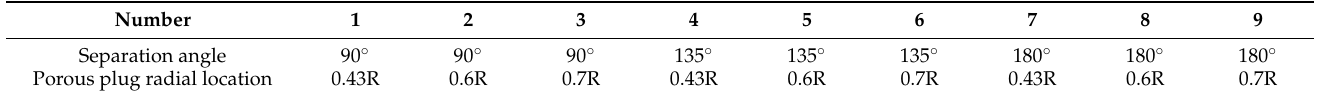
Table 4. Experiment scheme of optimal arrangement of porous plugs.